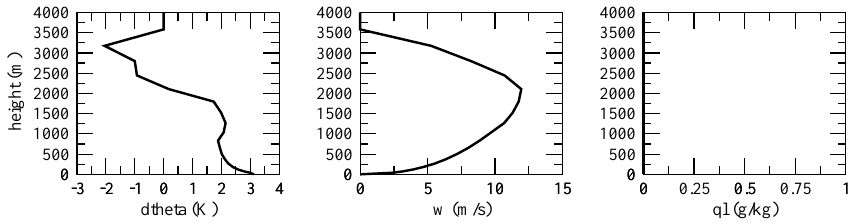
Fig. 5. Plume characteristics above the Kruger fire: virtual potential temperature excess (K), vertical velocity (m s − 1 ) and cloud liquid water (g kg − 1 ).